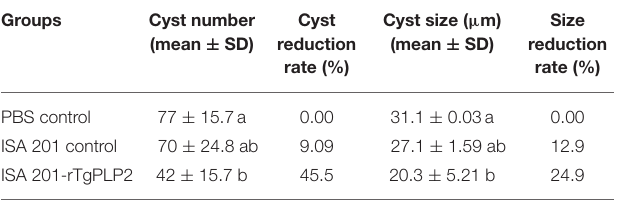
TABLE 3 | The number and size of PRU cysts in rTgPLP2 preimmunized mice brain.